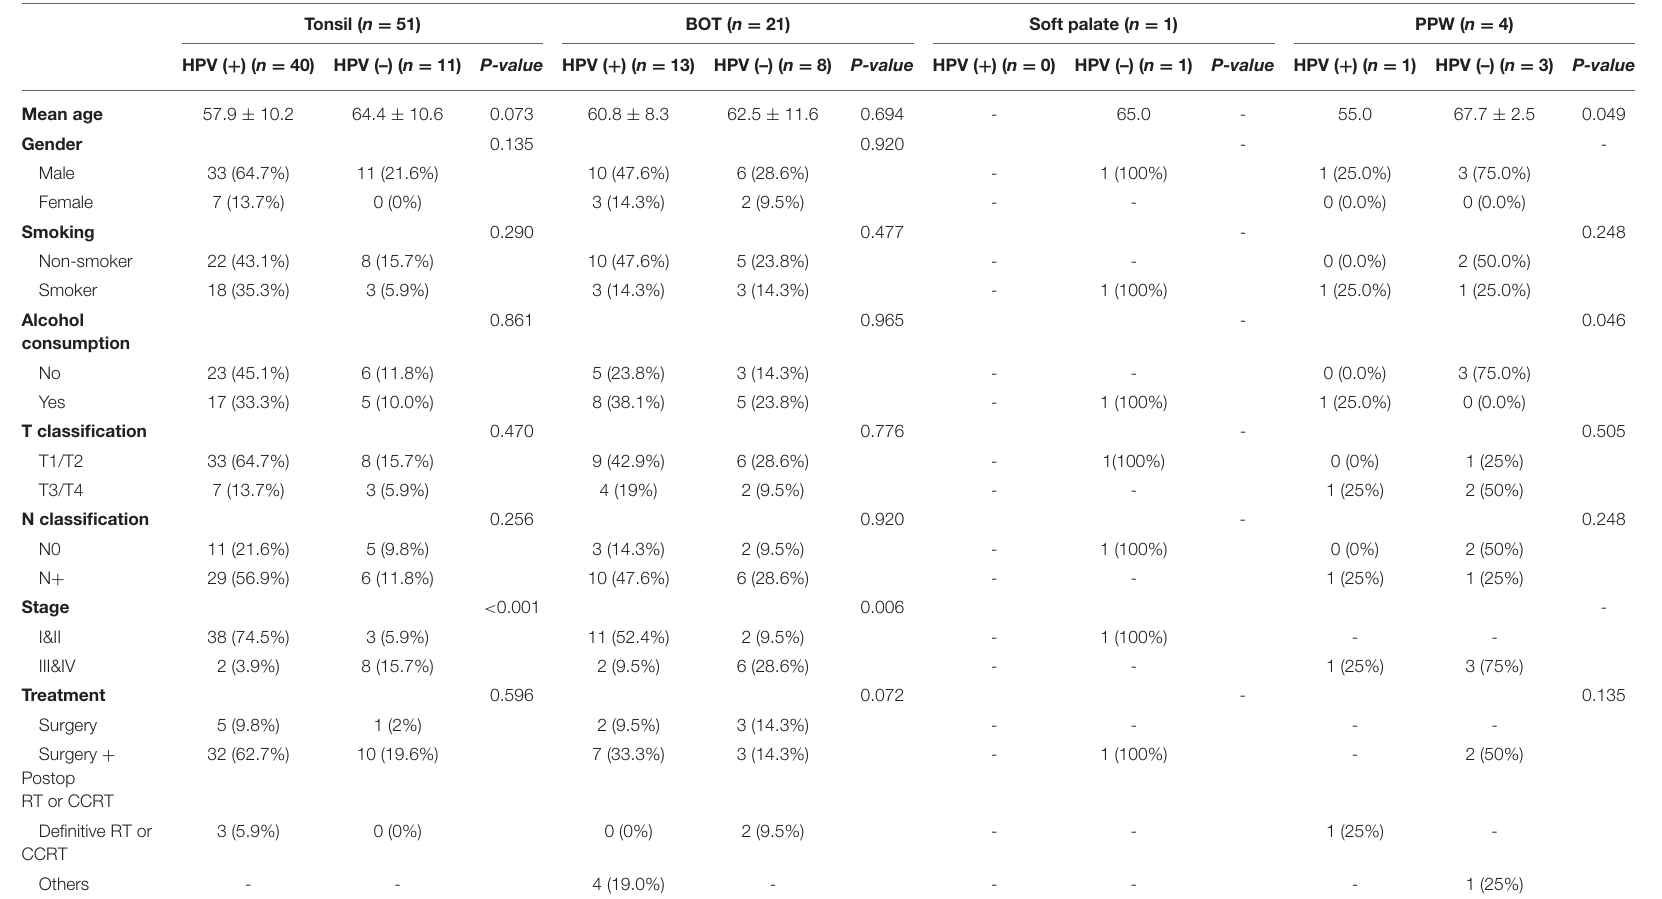
TABLE 3 | Comparisons of oropharyngeal squamous cell carcinoma according to the sub-site.